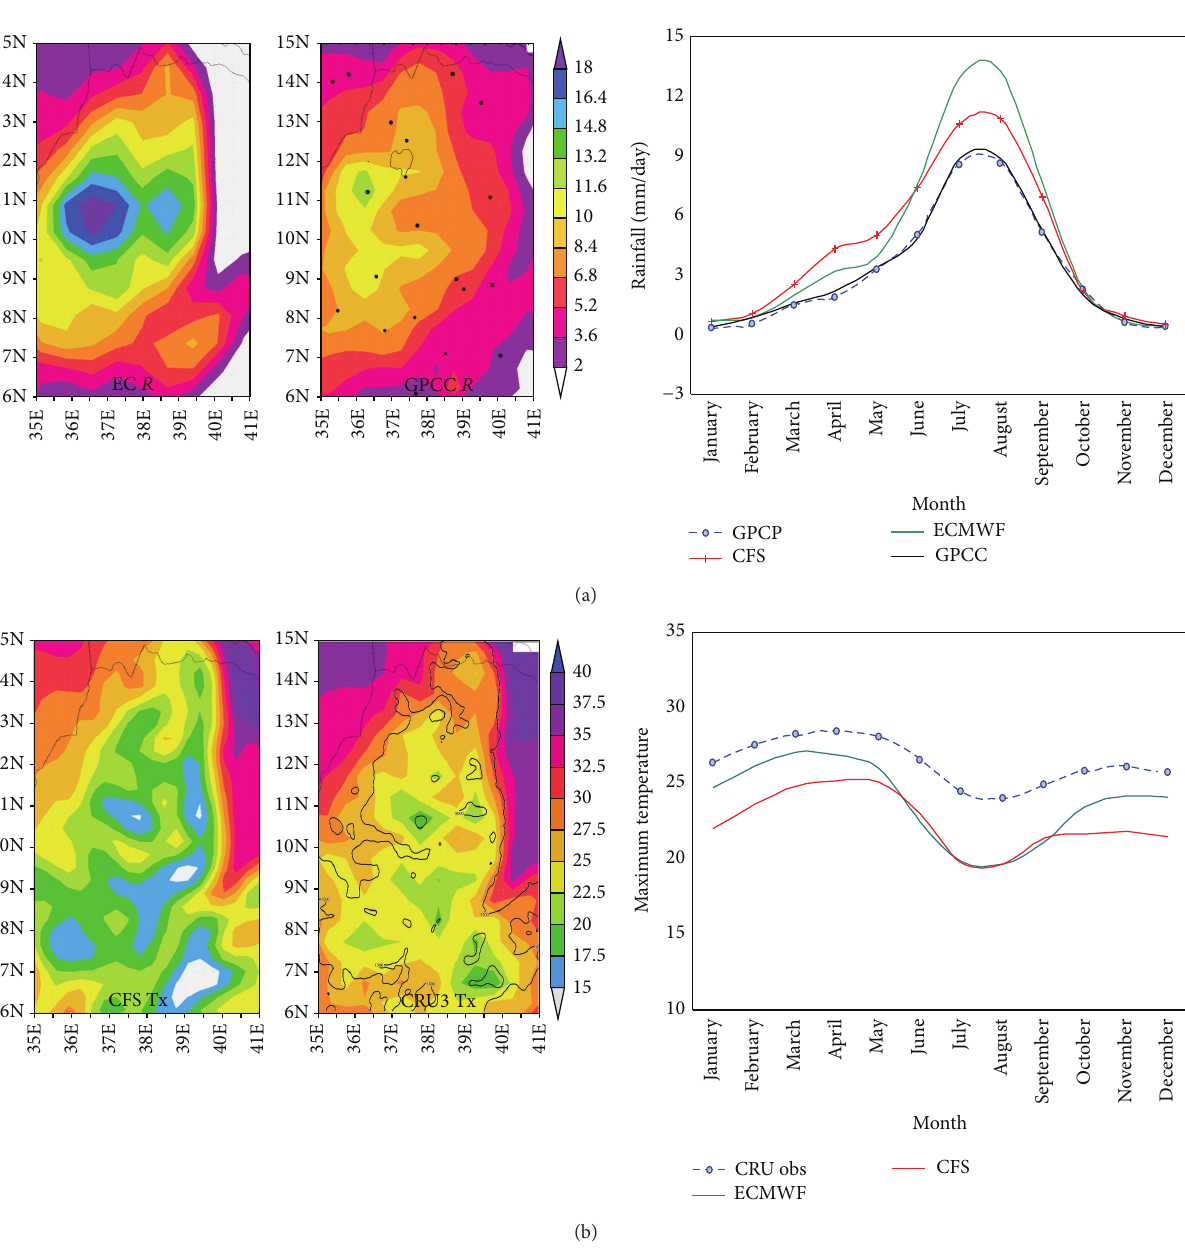
Figure 2: (a) JJA rainfall climatology from ECMWF (left) and GPCC observations (middle) with stations (dots) and annual cycle (right) comparing ECMWF/CFS models and GPCC/GPCP observations. (b) JJA maximum temperature climatology from CFS (left) and CRU3 observations (middle) with 1000 m/2000 m elevation contours and annual cycle (right) comparing ECMWF/CFS models and CRU3